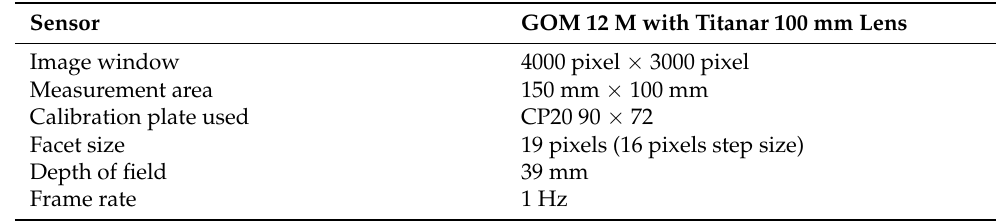
Table 3. DIC setup parameters.